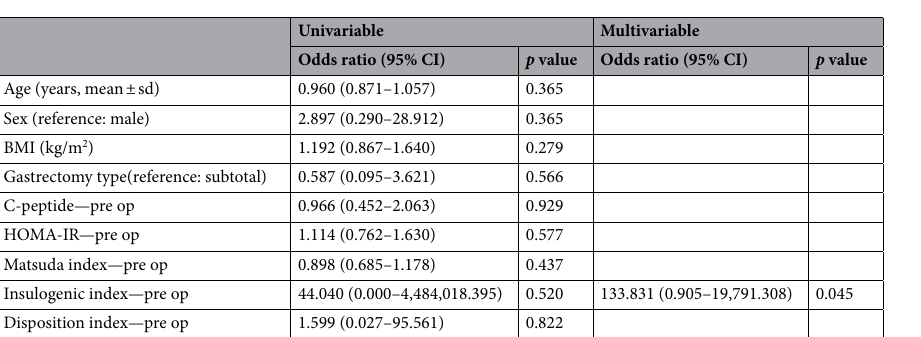
Table 3. Factors associated with T2DM remission * . *Logistic regression model with backward selection. BMI Body mass index, HOMA-IR Homeostatic model assessment of insulin